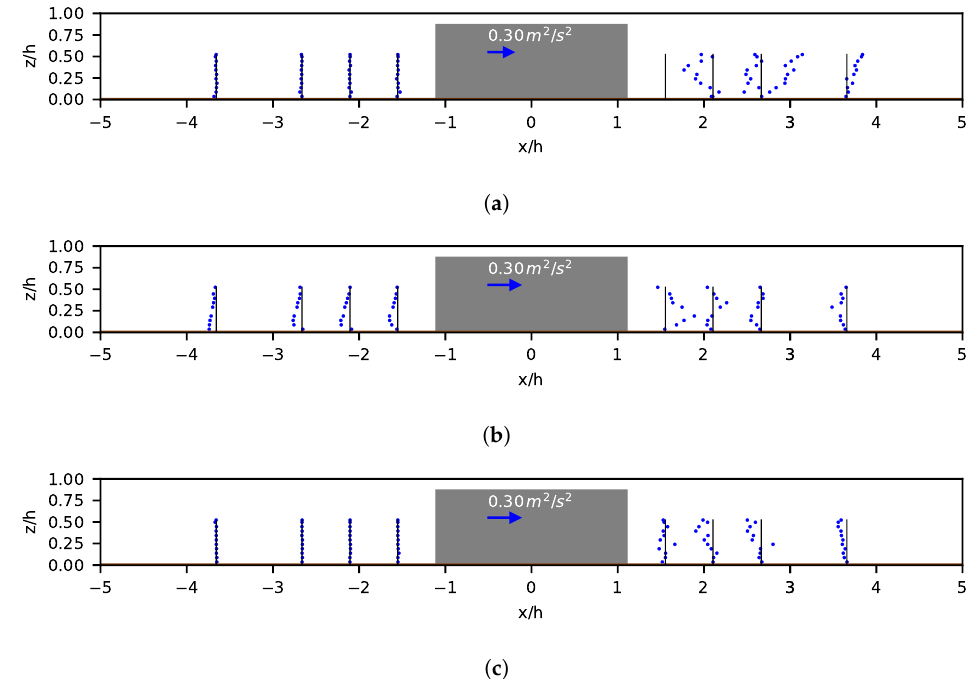
Figure 15. Vertical profiles of the Reynolds shear stresses along the pier’s mid-plane for Exp . 2 U Fbed . ( a ) Reynolds shear stresses ( u (cid:48) v (cid:48) ). ( b ) Reynolds shear stresses ( u (cid:48) w (cid:48) ). ( c ) Reynolds shear stresses ( v (cid:48) w (cid:48)